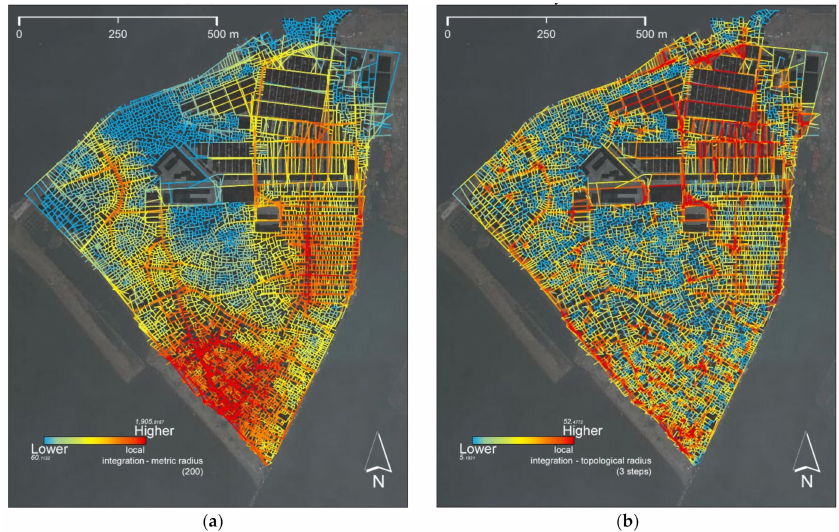
Figure 4. Configurational analysis of BaSECo informal settlement: ( a ) local integration index, metric radius 200; ( b ) local integration index, topological radius three steps. Graphics as Figure